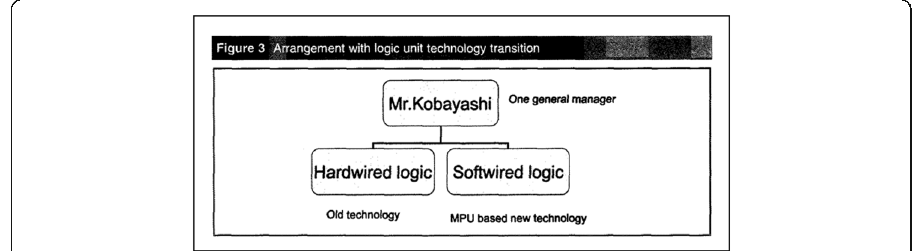
Fig. 5 Management arrangement with logic unit technology transition. Source: Shibata and Kodama T.